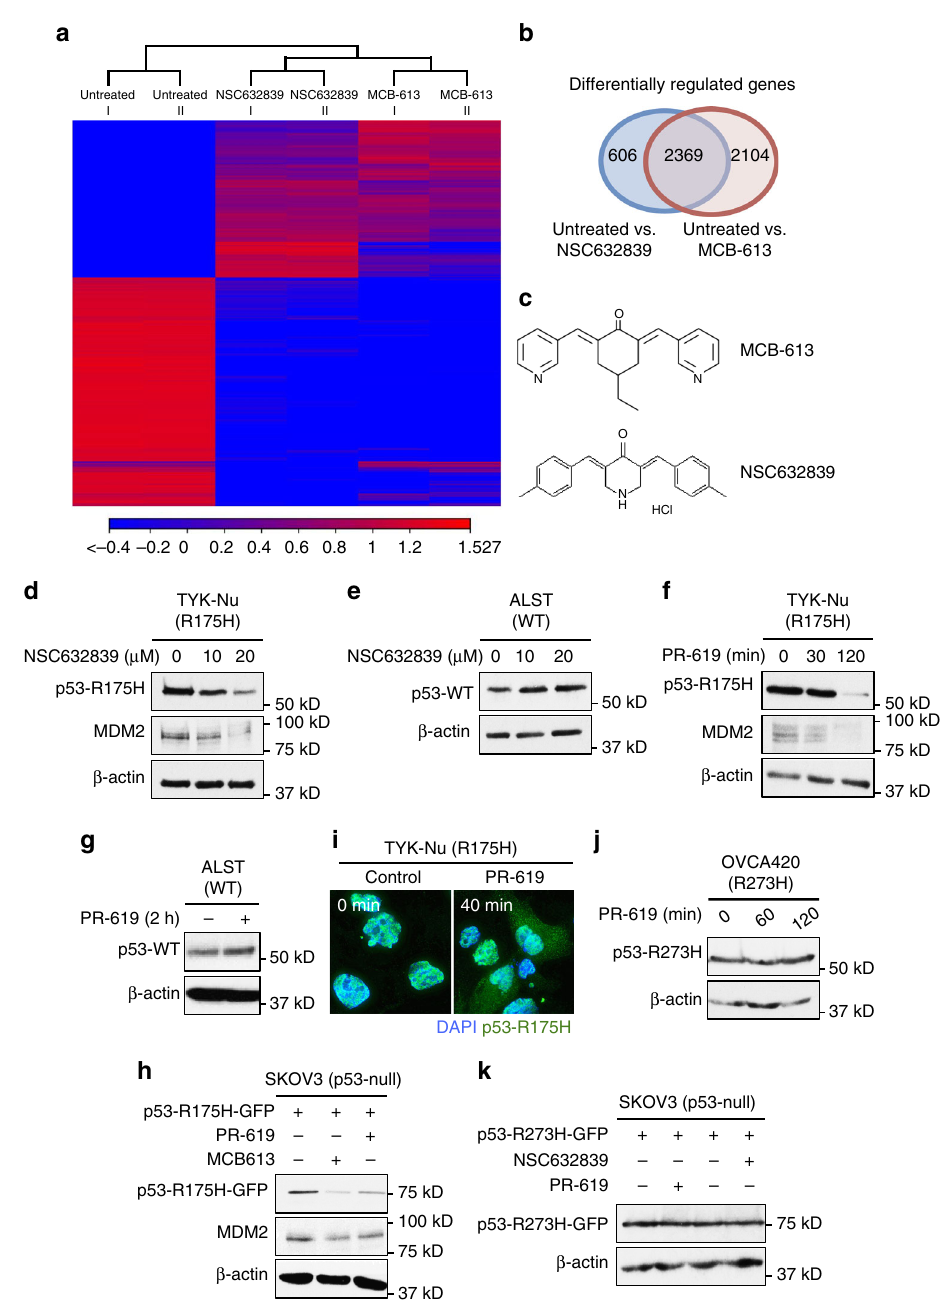
Fig. 5 DUB inhibitors mimic the effect of MCB-613 on p53-WT and p53-R175H. a Comparison of RNAseq data from MCF-7 cells treated with MCB-613 (6 h) and the DUB inhibitor NSC632839. b Venn diagram summarizing the result in Fig. 5a shows that the gene-expression changes induced by MCB-613 (6 h) and the DUB inhibitor NSC632839 in MCF-7 cells are highly similar. c Chemical structure of MCB-613 and NSC632839. d , e NSC632839 (20 µ M, 2 h) causes d depletion of p53-R175H and MDM2 and e slight increase in p53-WT levels. f , g PR-619 (10 µ M, 2 h) causes f depletion of p53-R175H and MDM2 and g slight increase in p53-WT levels. h Effect of MCB-613 (6 µ M, 2 h) and the pan-DUB inhibitor PR-619 (10 µ M, 2 h) on ectopically expressed GFP tagged p53-R175H protein and endogenous MDM2 in SKOV3 cells (p53-null). i PR-619 causes cytoplasmic localization of p53-R175H (green). j Effect of PR-619 (10 µ M) on p53-R273H mutant protein in OVCA420 cells. k Effect of DUB inhibitors PR-619 (10 µ M, 2 h) and NSC632839 (20 µ M, 2 h)